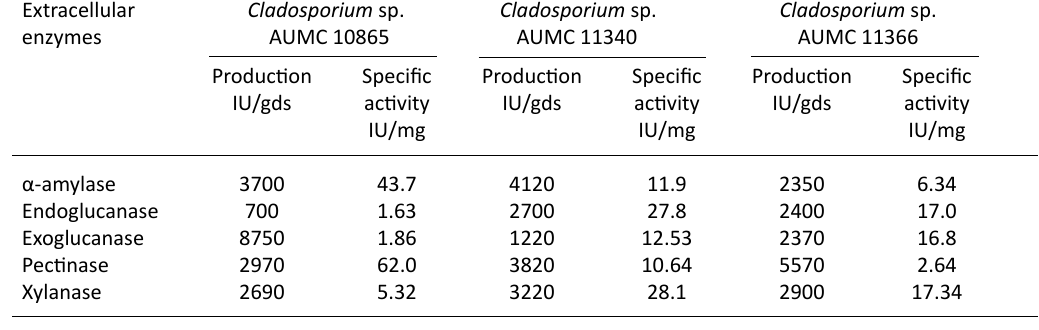
Table 2. Production and specific activity of amylase, endoglucanase, exoglucanase, pectinase and xylanase enzymes produced by Cladosporium isolates AUMC 10865, AUMC 11340 and AUMC 11366 in SmF at 30°C Extracellular Cladosporium sp. Cladosporium sp. Cladosporium sp.